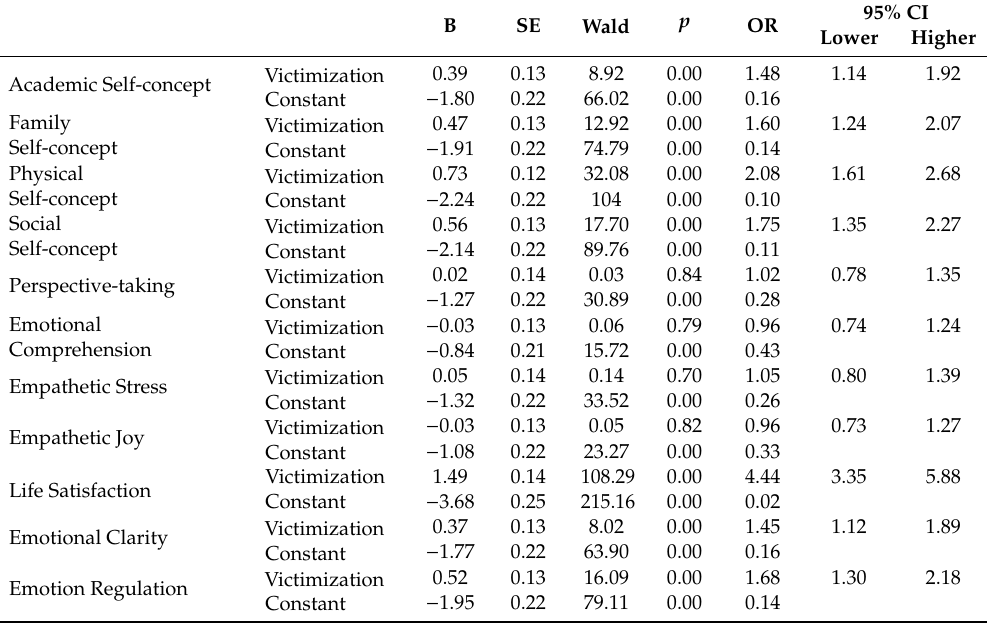
Table 5. Logistic regression with traditional victimization as a predictor of low scores.